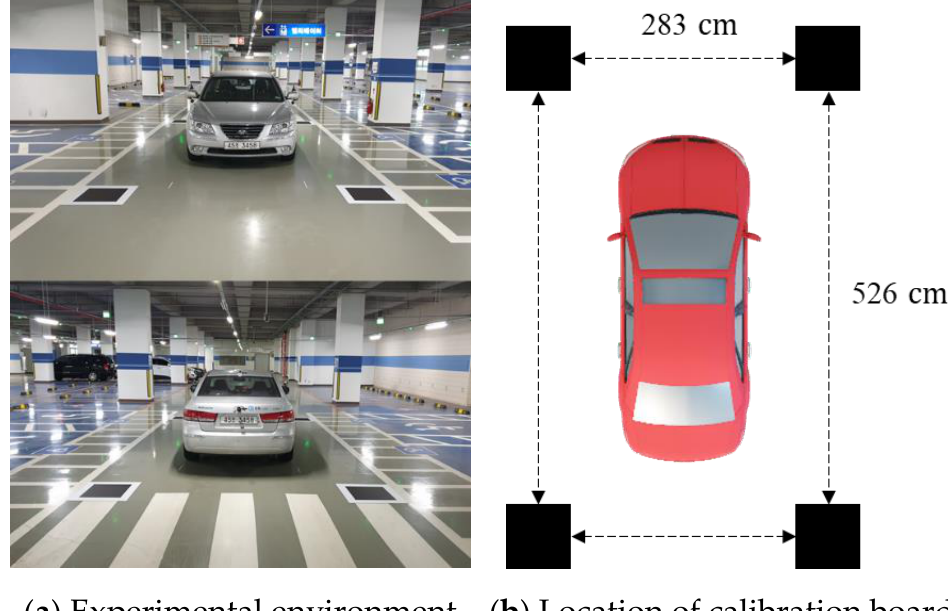
Figure 16. Aligned calibration boards in the conventional method.